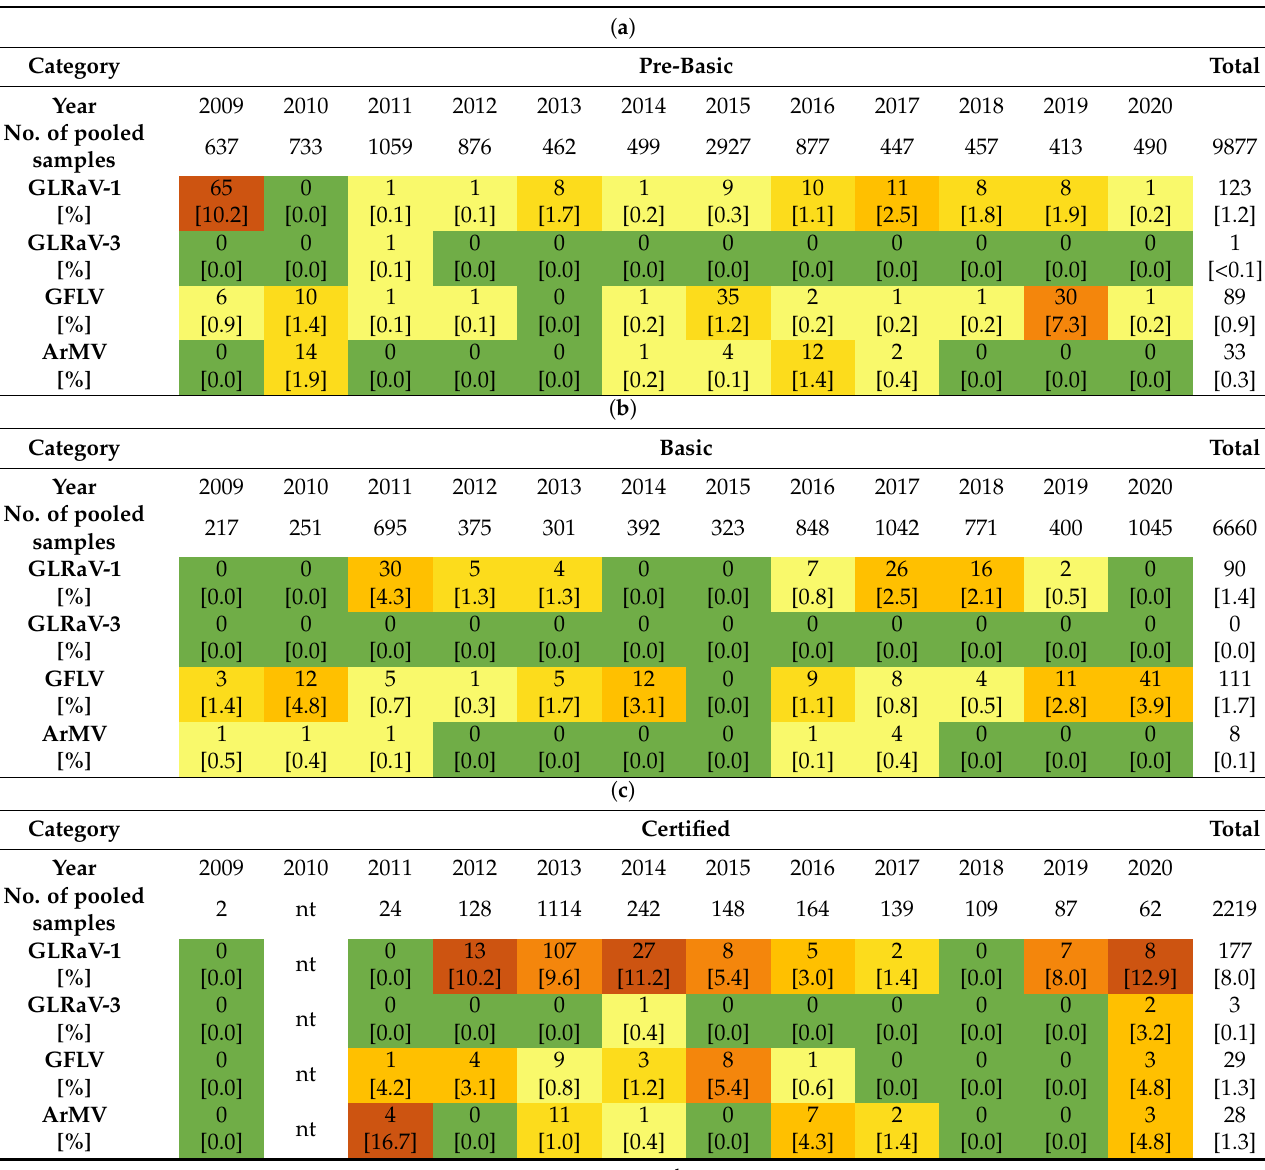
Table 1. ELISA results of scion propagation material from 2009–2020, separated by categories. The table shows the amount of positive tested samples for each virus and the percentage relative to the total number of pooled samples of the year in question (square brackets). Samples were tested for Grapevine fanleaf virus (GFLV); Arabis moasic virus (ArMV); Grapevine leafroll asscoiated virus 1 (GLRaV-1); Grapevine leafroll associated virus 3 (GLRaV-3). Listed are the virus tests of pre-basic (a), basic (b), and certified plant material categories (c). Individual years are color coded depending on the virus